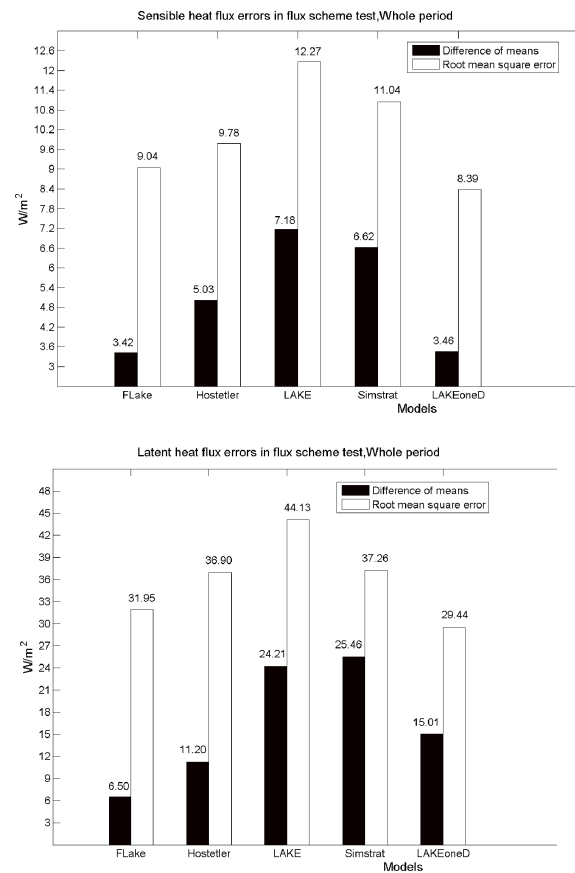
Fig. 8. Difference between computed and observed means and RM- SEs of sensible and latent heat flux by stand-alone surface turbulent flux schemes. The mean measured sensible heat flux is 8Wm − 2 , and mean latent heat flux is 69Wm − 2